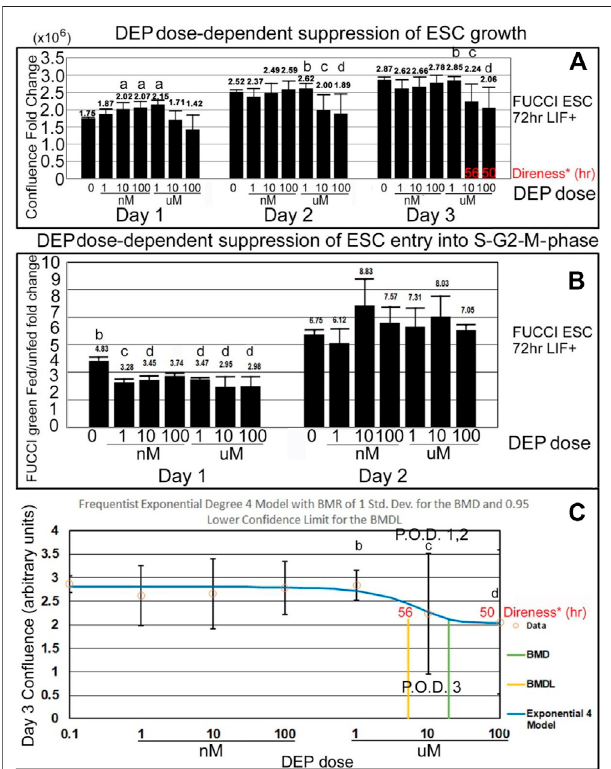
FIGURE8| DEPsuppresses accumulatedgrowth asalagging indicator measured by con fl uence and suppresses entry into the S-G2-M phase after medium change as a leading indicator predicted during ESC culture with LIF. (A) FUCCI ESCs are cultured and assayed as shown in Figure 4 , and data shown in Figures 7A,B are further analyzed for dose-dependent suppression of con fl uence and entry into the green S-G2-M-phase of the cell cycle. Con fl uence FC from timepoints on days 1, 2, and 3 were compared to timezero (T26/T0,T52/T0, and T74/T0),forDEPdosesshown.Asdataofthe con fl uences of the wells before the fi rst feeding of the toxicant are not known, T0usedwasthe fi rsttime-lapserecorded(T2)forNS. (B) Theamountofgreen intensity at the peak after feeding and the nadir before feeding are rationated. Ingeneral,thegreenfoldchangedecreasesasthedoseofDEPincreases. (C) Day 3 con fl uence FC from A was analyzed, using the Benchmark dose as point of departure. For DEP, we chose the frequentist Exponential degree 4 v1.1 model because it has the lowest AIC and the highest p -value (though still < 0.1).Allthemodelsweredeemedquestionable.FortheExponential4model, the constant variance test failed (test two p -value < 0.05). Also, BMD/BMDL ratio > 3 and modeled control response std. dev. > |1.5| actual response std. dev. NS (0 dose): N isdescribed in Figure 1 . DEP: Nis described in Figure 7 . NOAELs are shown with (b) and LOAELs are shown with (c). Growth during the fi rst day is signi fi cantly faster than NS for some intermediate doses (a) ( p < 0.05).Day1peak,occurringaftertheT24feeding,showsanearlyreductionin greenFCat1 nM( p < 0.01).ThisLOAELisnotreplicatedinFCforday2peak. (d) are doses that are signi fi cantly different from NS but not the LOAEL (A: p < 0.05, B: p ranges from < 0.05 to < 0.01) C: BMD (cid:1) 19.2 uM, BMDL (cid:1) 5.29 uM.